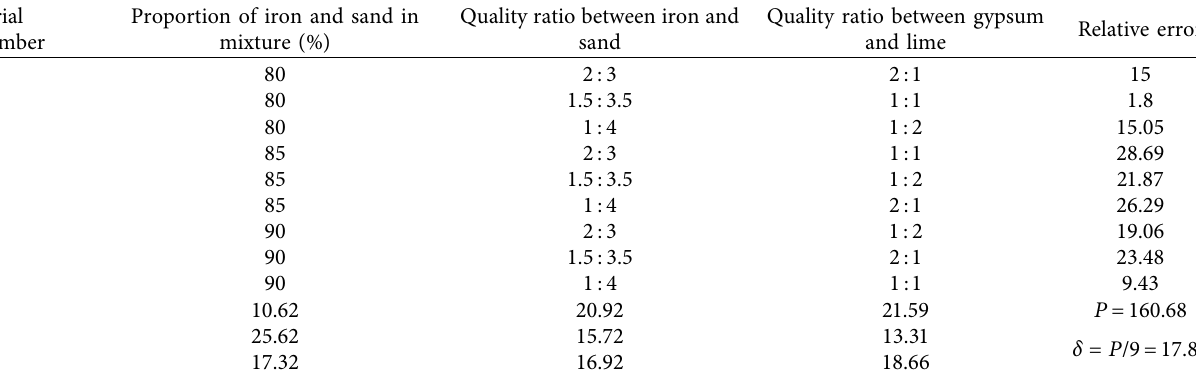
Table 9: Cohesive force of relative error analysis.